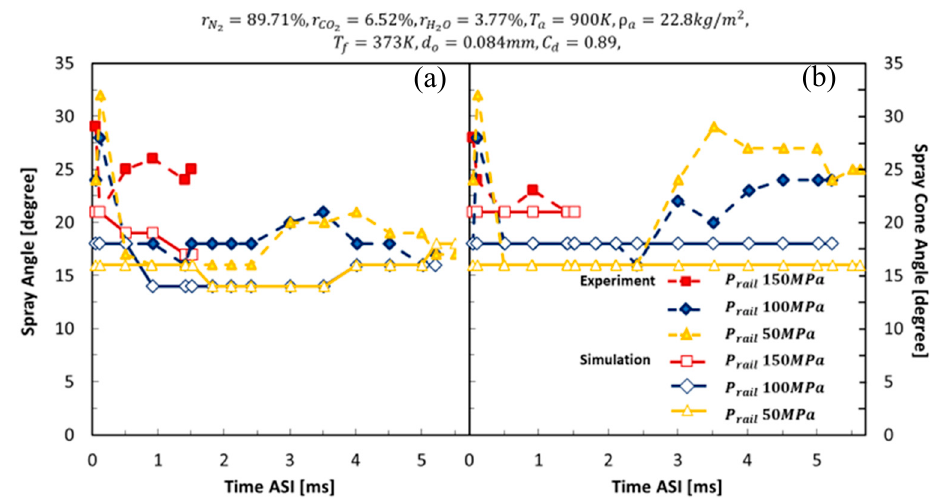
Figure 11. Comparison of the spray distribution angle for different rail pressures. ( a ) Spray angle and ( b ) spray cone angle.